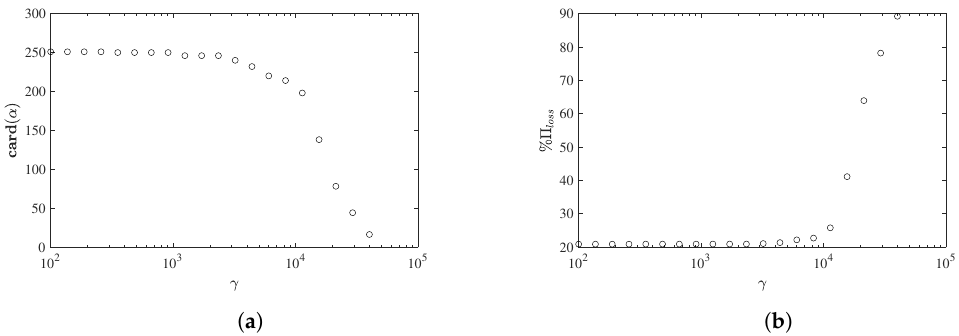
Figure 7. The sparsity level card ( α ) ( a ) and the optimal performance loss % Π loss ( b ) for different values of the sparsity parameter γ .